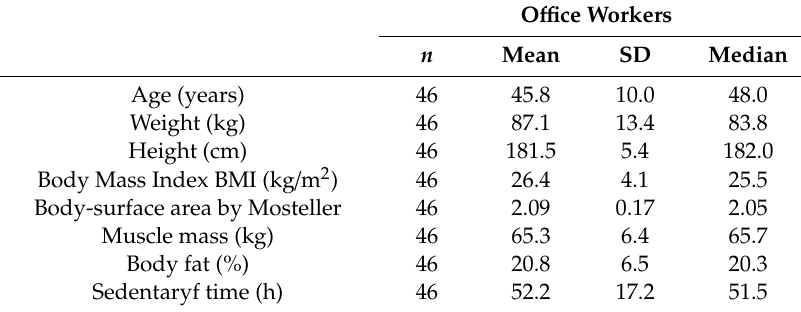
Table 1. Basic characteristics of the study population.